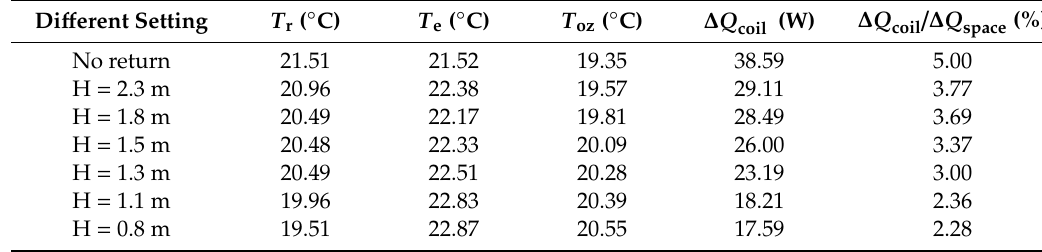
Table 4. Energy saving for heating